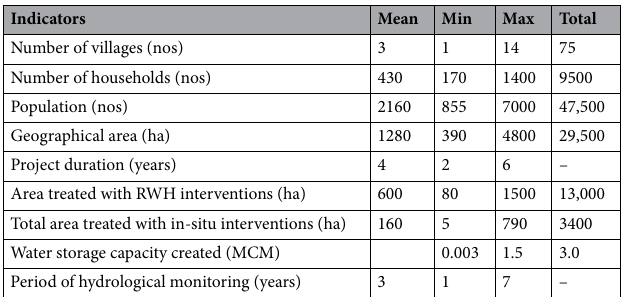
Table 1. Summary of demographic and project interventions undertaken in study watersheds between 1999 and 2016.